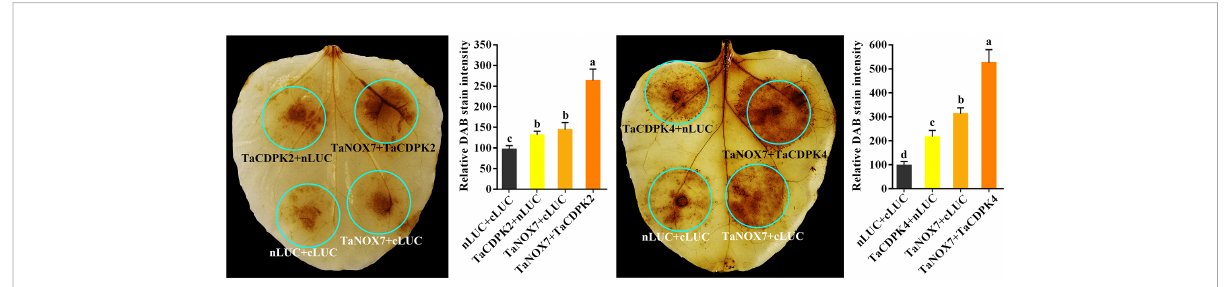
FIGURE 8 TaCDPK2/4-TaNOX7 interactions enhanced ROS production in plants. Transient coexpression of TaNOX7 with TaCDPK2 or TaCDPK4 all enhanced ROS production in the leaves of N. benthamiana . The level of ROS accumulation was detected by the method of DAB (3, 3´- diaminobenzidine) staining method. The DAB staining intensity in in situ ROS levels of the agroin fi ltrated tobacco leaves was calculated based on the stain intensity of the control “ cLUC + nLUC ” . Data are means ± SD (n = 10~15 leaves) from more than three independent experiments. Bars annotated with different letters represent values that are signi fi cantly different at P ≤ 0.05 according to one-way analysis of variance (ANOVA) analysis.